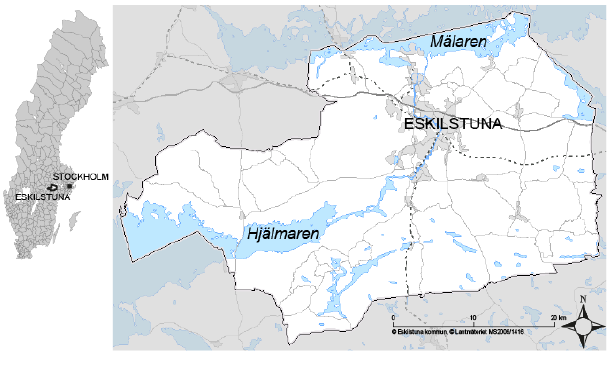
Fig. 1 . Eskilstuna municipality in Sweden. The municipality borders Lake Mälaren to the north and Lake Hjälmaren to the west. The biggest city, also called Eskilstuna, is situated in the middle of the municipality. The grey areas are urban, whereas the rest of the municipality is a mix of forested and agricultural land.